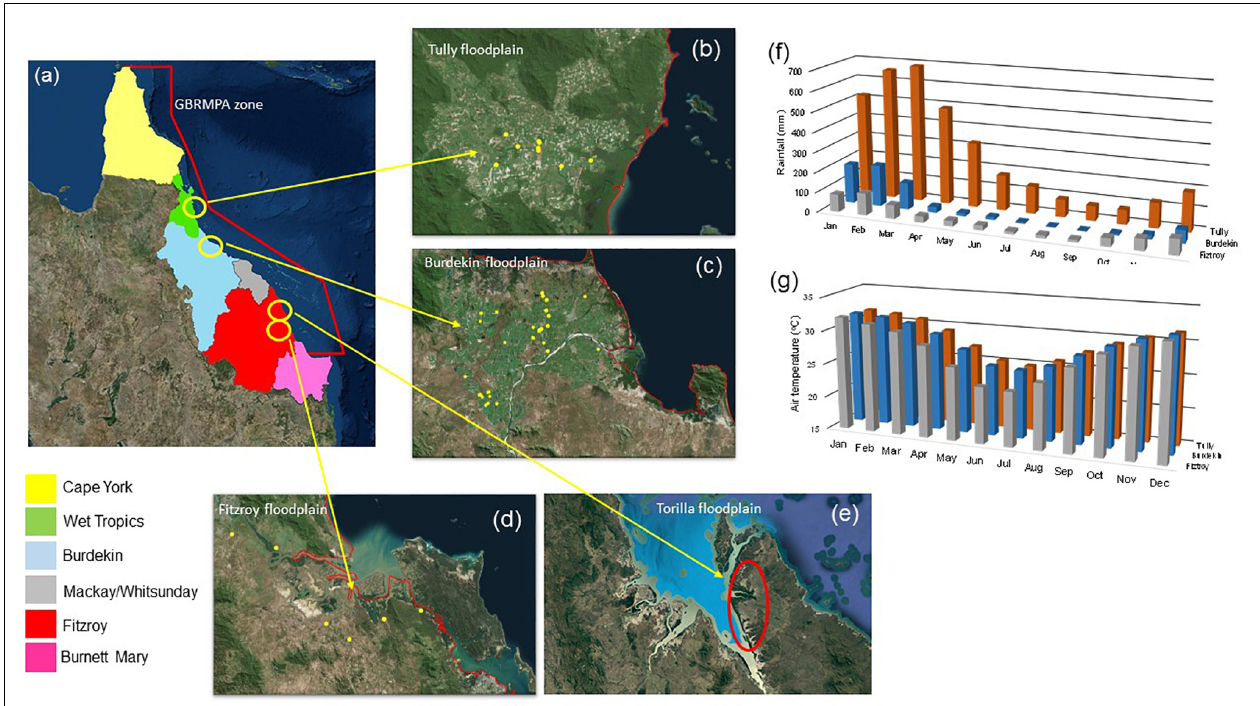
FIGURE 1 | (a) Location map of the Great Barrier Reef World Heritage Area (GBRMPA) along the Queensland coastline, including NRM regional bodies (see Figure 3 ). (b) Tully floodplain; (c) Burdekin floodplain; (d) Fitzroy floodplain along with field fish sampling completed in previous surveys; (e) Torilla floodplain in Broad Sound catchment. (f) Monthly average rainfall totals at gauging stations in each floodplain area [Tully gauging station 32042 (1925–2018); Burdekin station 33001 (1887–2018); Fitzroy station 39083 (1939–2018)]; and (g) monthly ambient air temperature records at BOM recording stations [Tully station 032004 (1871–2018); Burdekin station 33002 (1951–2018); and Fitzroy station 39083